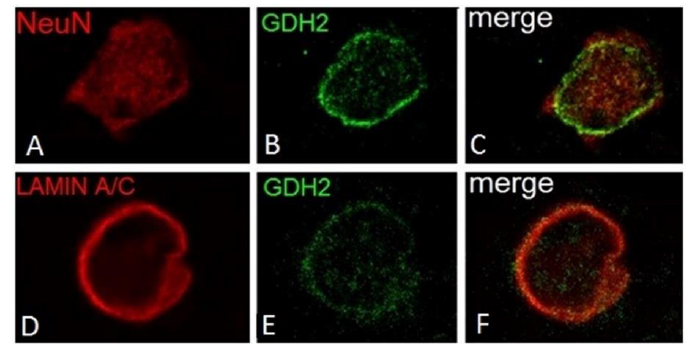
Figure 5. Association of hGDH2 with the nuclear membrane in small cortical neurons. A delicate circular GDH2 specific-staining is detected around the NeuN-positive area ( A – C ). Double IF using anti-hGDH2 and anti lamin A/C specific antiserums revealed that hGDH2 co-localizes with Lamin A/C on the nuclear membrane of this cell ( D – F ). (IF images of unfixed human frontal lobe cortex).